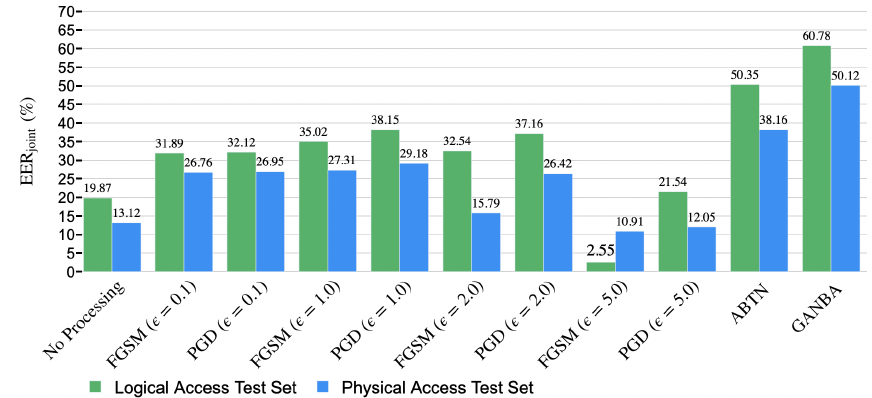
Figure 4. EER joint (%) of the white-box adversarial spoofing attacks evaluated on the ASVspoof 2019 logical and physical access test datasets. The ASV and PAD systems are the state-of-the-art TDNN + PLDA and LCNN systems,